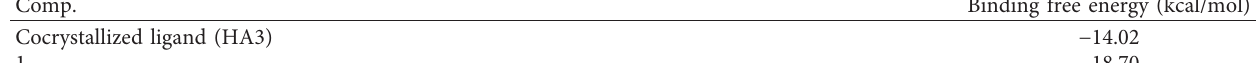
Table 2: The docking binding free energies of compound 1 and the cocrystallized ligand (HA3) HDAC. Comp.